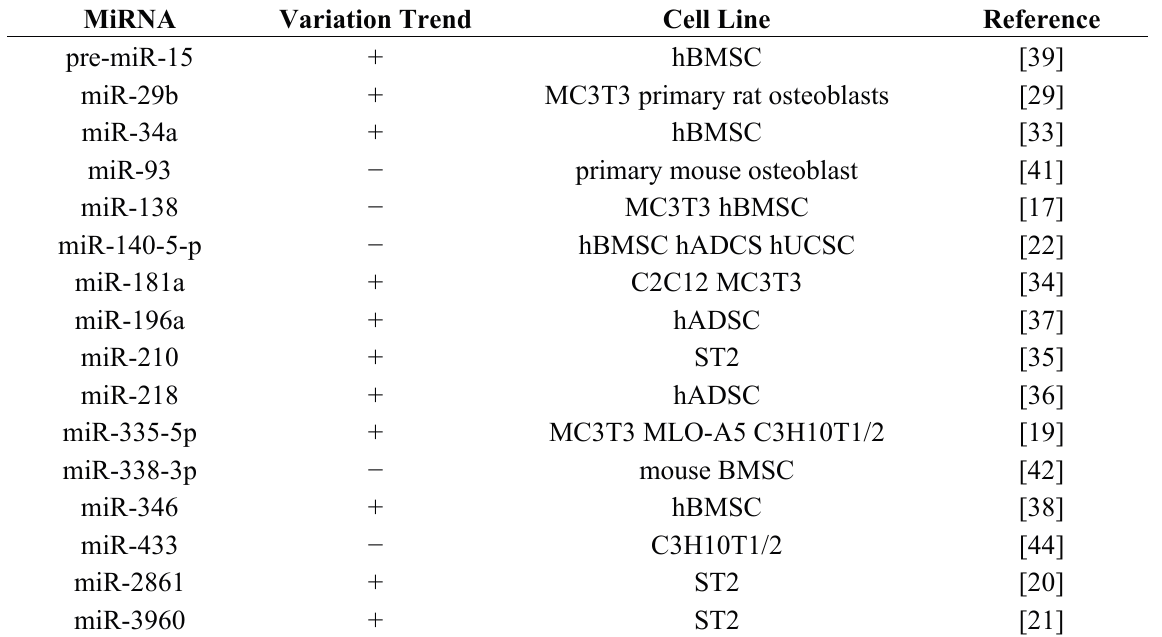
Table 1. Dynamic changes of miRNAs during